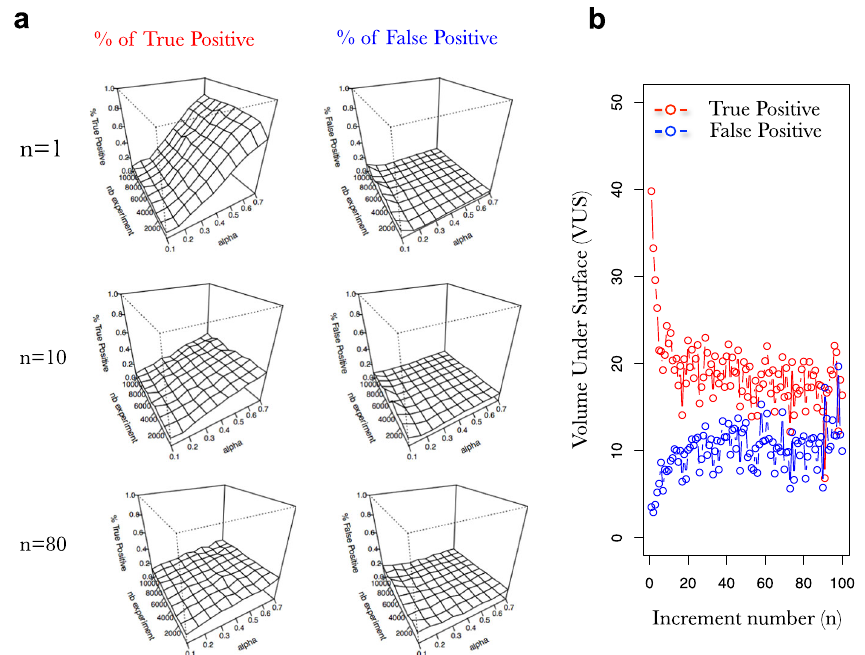
Fig. 6 Small increment in gene expression are more powerful to properly learn the network with SVM and prior knowledge than steady states. a Surfaces exploring the SVM accuracy (% of true positive on left and % false positive in right ) to predict the connections in a FRANK generated network (100 TF, 1000 TA) using an increasing number of simulated gene expressions ( nb experiment ; y -axis) and an increasing fraction of the network as prior knowledge ( alpha [rows are used as prior knowledge]; x -axis). Percentage of true positive and false positive are evaluated based on predictions of the presence of an edge and its positive or negative in fl uence. b Progression of the volume under the surface (as in a ) computed for a progression in (A + I) n for the % of true positive ( red ) and the % of False positive ( blue ) predicted connections in the network. Simulated gene expression data kind: multistart (A 1 , … , A 100 ); prior knowledge data kind